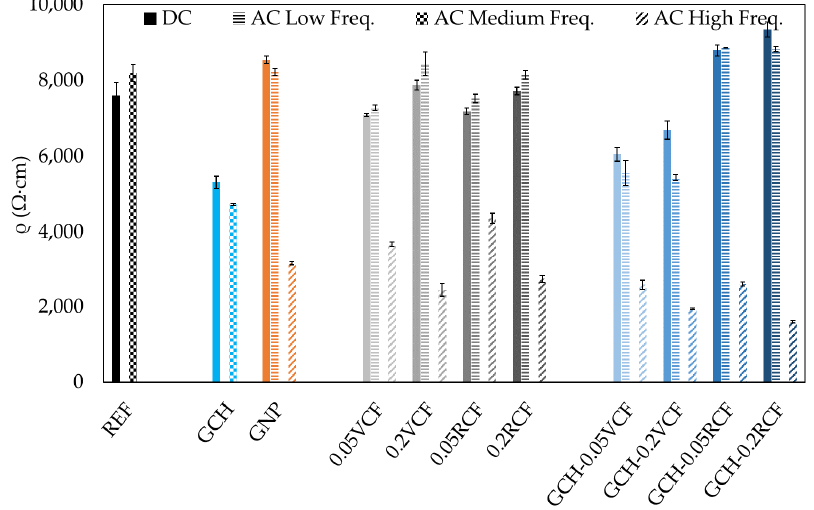
Figure 11. Electrical resistivity ( ρ ) of mortars after 28 days of curing measured in both DC and AC.